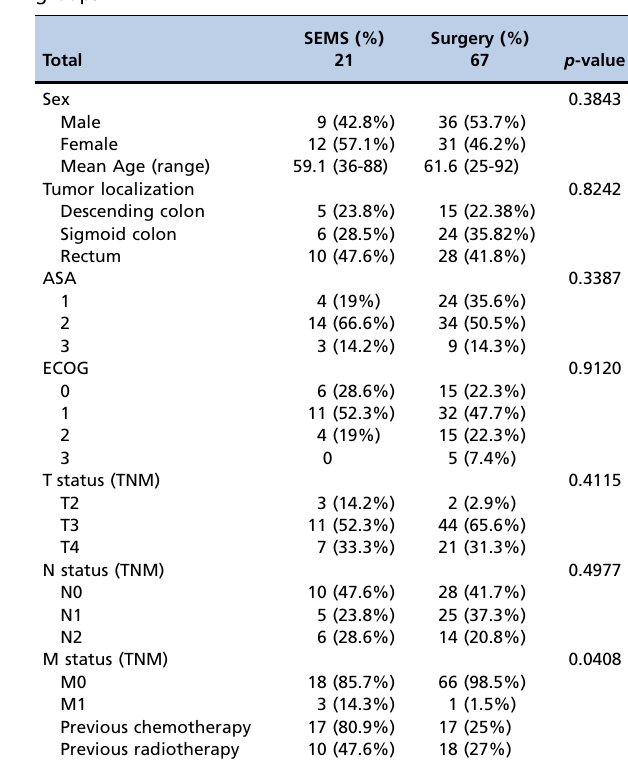
Table 1 - Baseline clinical characteristics of patients in both groups.